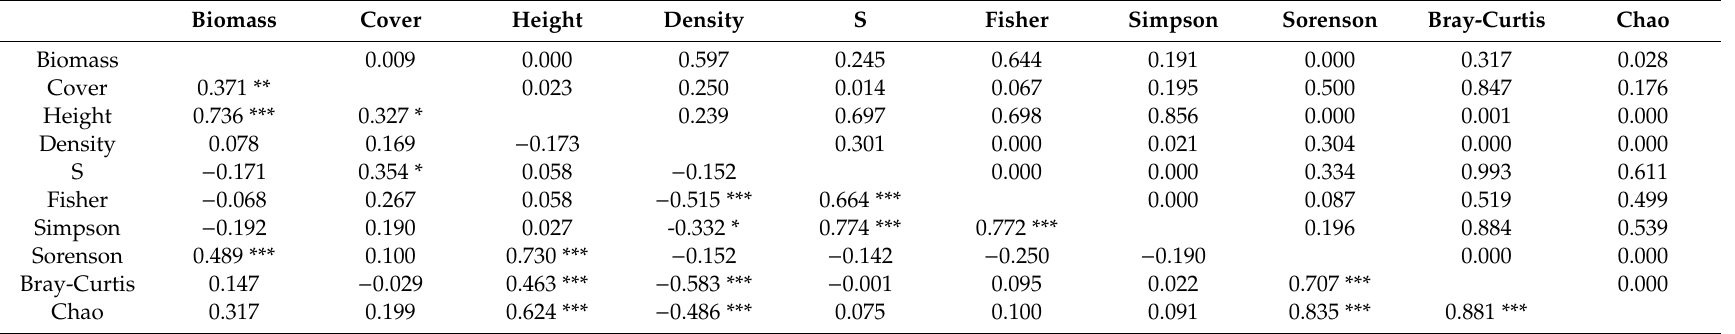
Table 5. Correlations among vegetation structure variables. p -value of significance test Pearson correlation coe ffi cients are listed above and below diagonal,